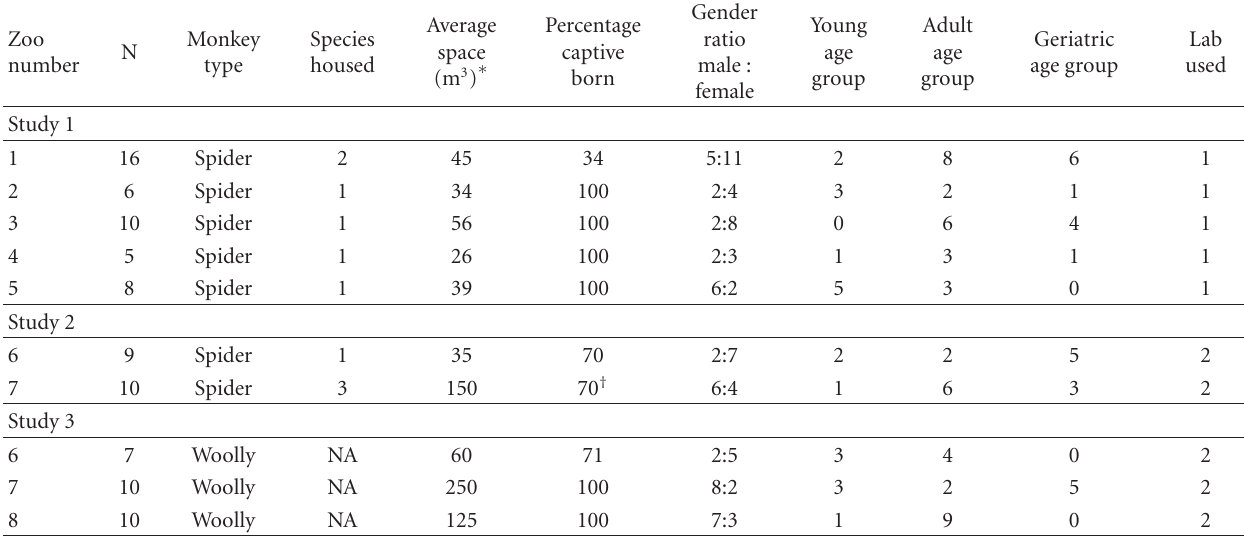
Table 1: Monkey management and housing information from the zoological institutions housing spider and woolly monkeys. Zoo N number